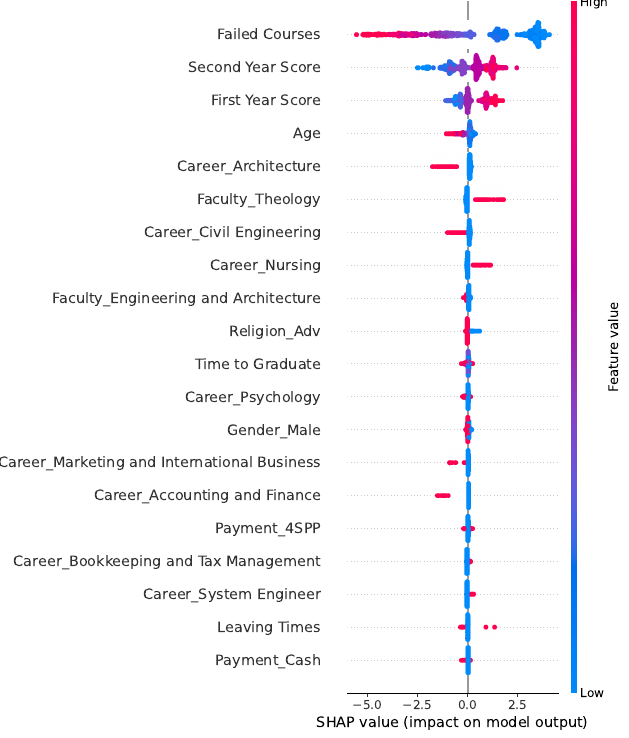
Figure 10. Shap-values for XGBoost, indicating the most important features of the predictive model generated by this